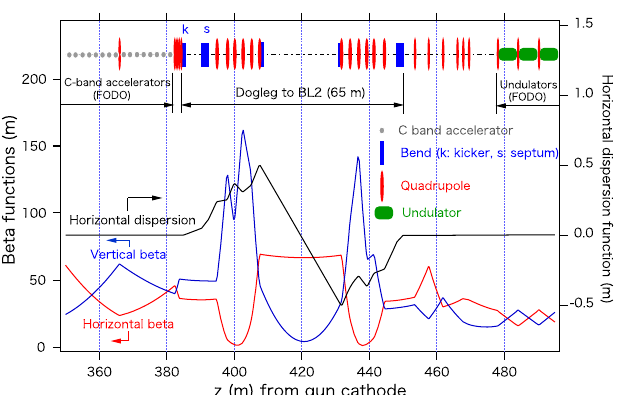
FIG. 2. Electron beam optics and magnet configuration for the beam transport from the end of the accelerator to the BL2 undulators. Solid lines indicate the horizontal beta function (red), vertical beta function (blue), and horizontal dispersion function (black), respectively. The inset on top shows the magnet